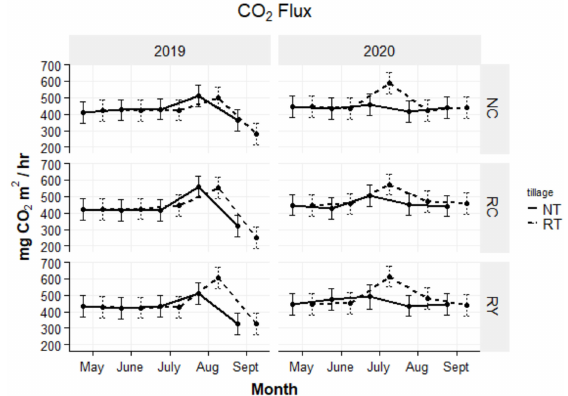
Figure 4. CO ₂ flux within treatments.